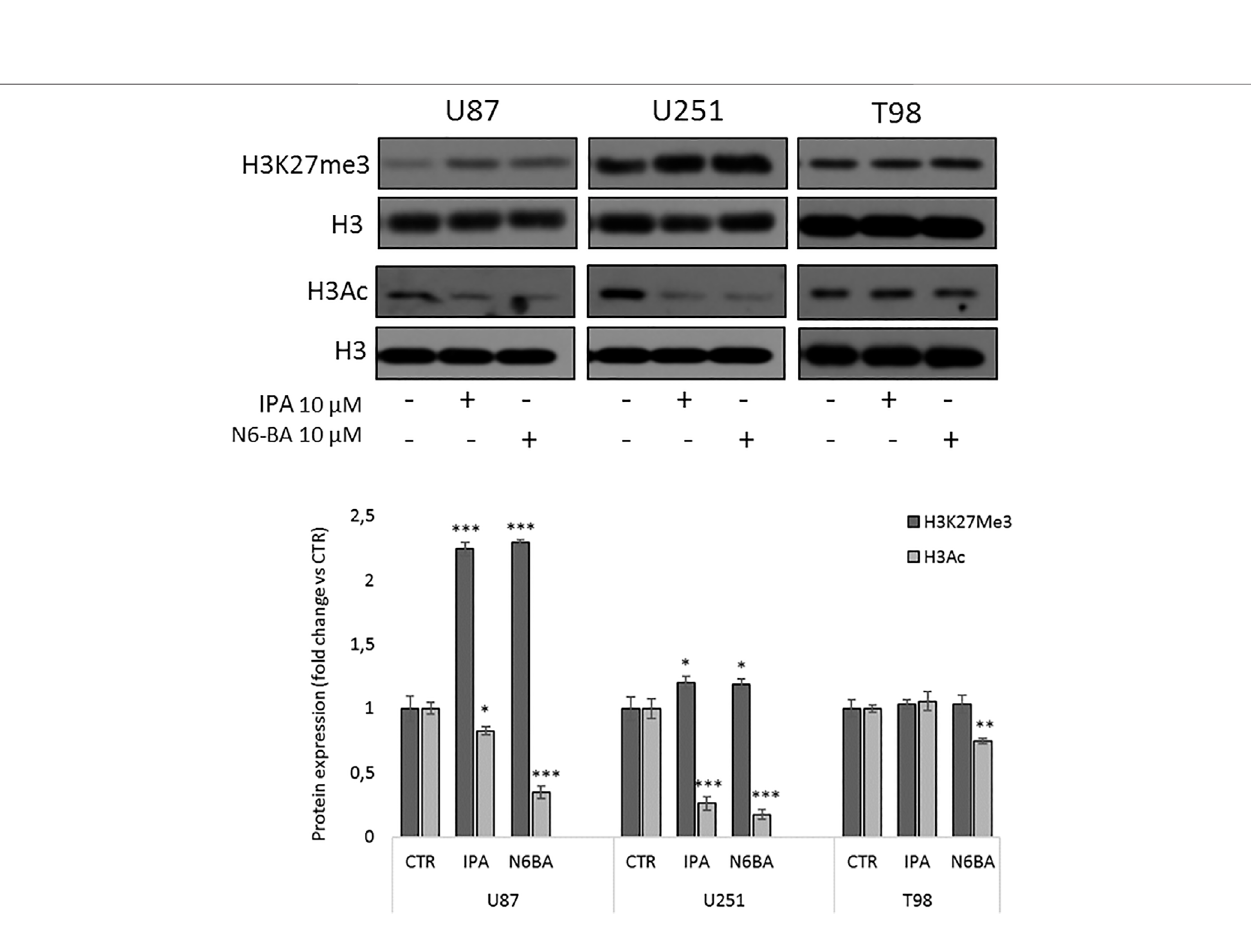
Frontiers in Pharmacology |